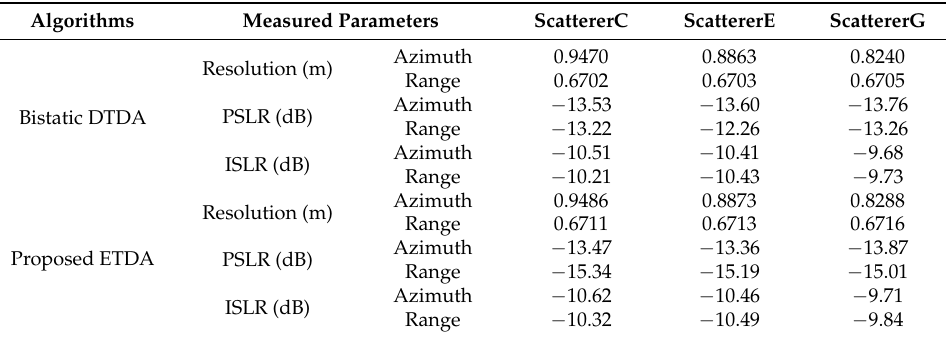
Table 2. Measured parameters of the selected point-like